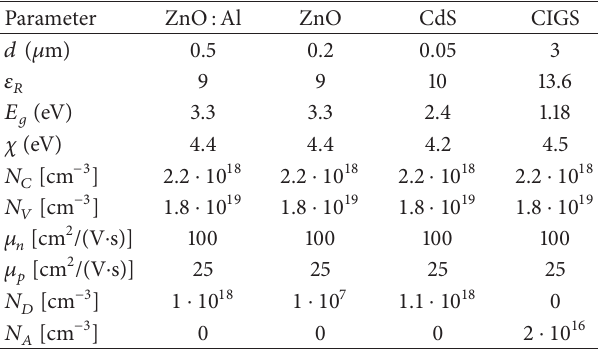
Table 1: Simulation material parameters of the CIGS thin-film solar cell.